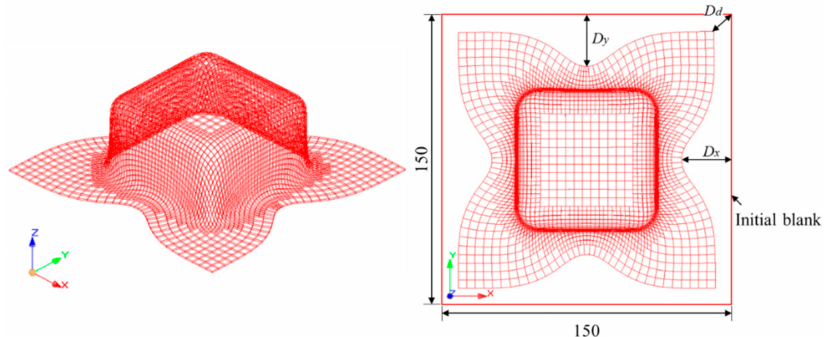
Figure 7. Part mesh and definition of the draw-in length. Adapted from Ref. [33] with permission from Elsevier (2021).